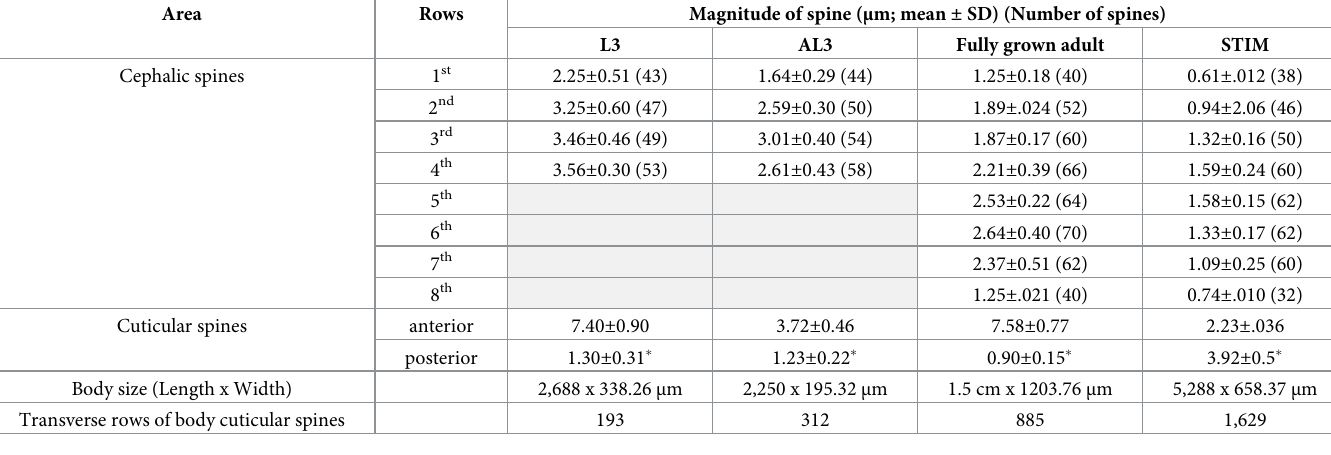
head) ( Fig 3H ). In contrast, the L3 ( Fig 3E ) and AL3 forms ( Fig 3F ) showed clear striation with transverse rows of body cuticular spines. Ellipsoidal cervical papillae without spines var- ied between rows 9 and 10 in the larval stage of L3 and AL3 to between rows 20 and 22 of cutic- ular spines in more developed pre-adult and adult stages ( Fig 3 ). The body cuticular spines Table 2. Comparative morphological characteristics of the STIM specimens with other stages of G . spinigerum under scanning electron microscopy. Area Rows Magnitude of spine ( μ m; mean ± SD) (Number of spines) L3 AL3